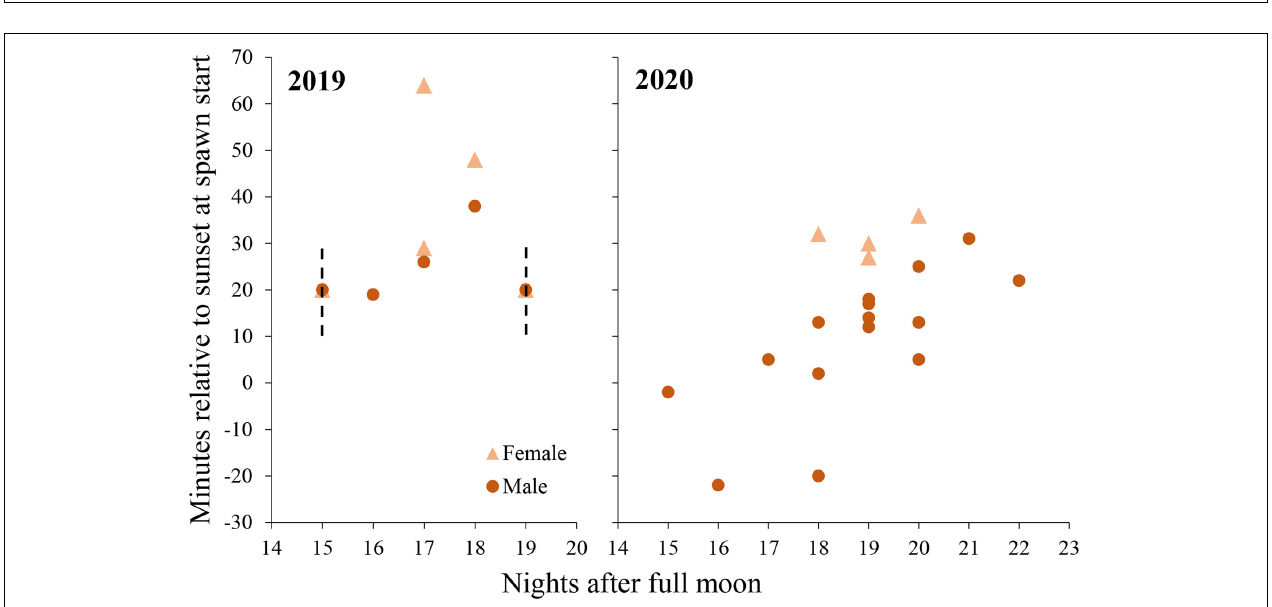
FIGURE 5 | Male M. meandrites colony releasing sperm during the September 2019 ex situ induced spawning event.